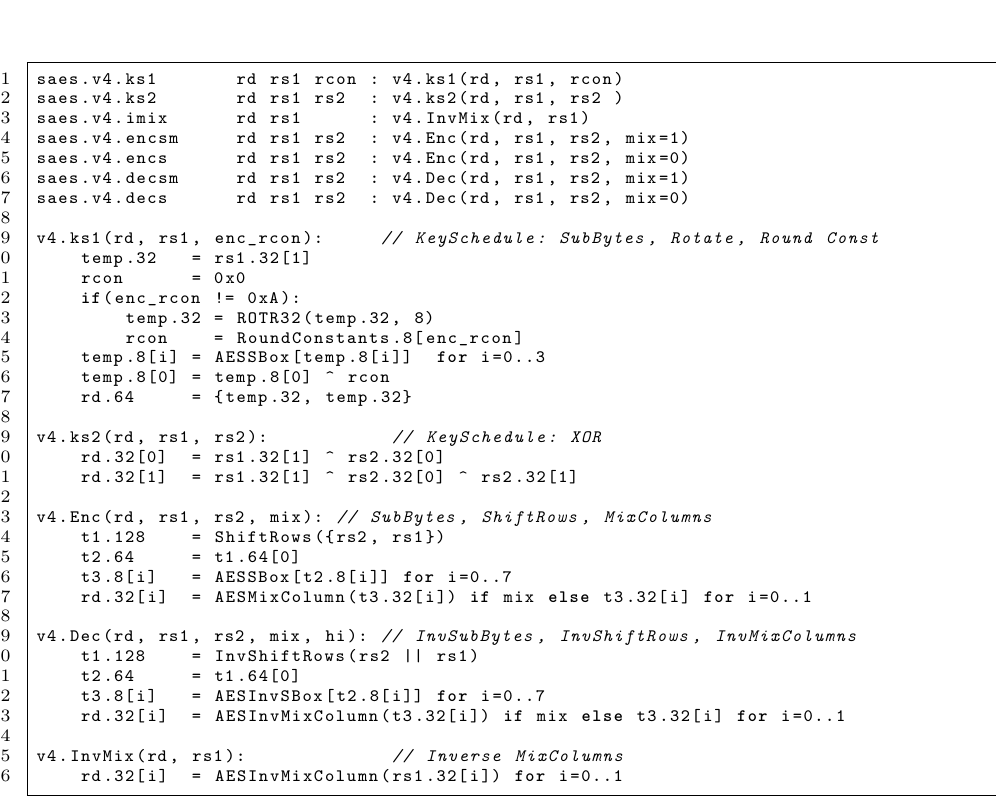
Figure 5: Instruction mnemonics, and their mapping onto pseudo-code functions, for V 4 .